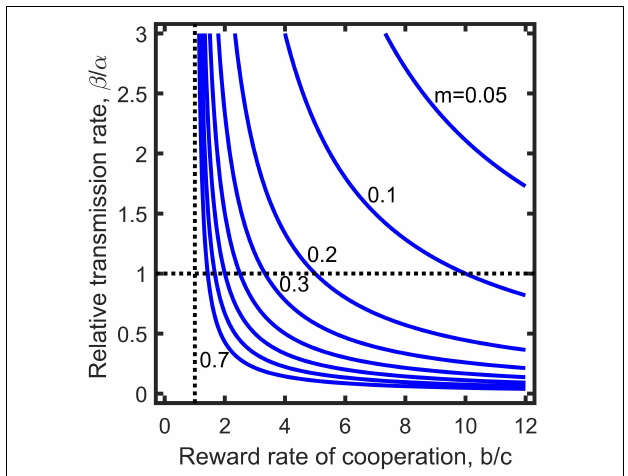
FIGURE 2 | Invasion threshold of pathogenic diseases to the population of cooperation evolution when transmission by interaction is absent (Equation 9). The parameter values taken above the curves assures invasion successful, otherwise, below which invasion fails. Vertical dashed line indicates cooperation benefit is equal to cost (i.e., b c = 1), and horizontal dashed line separates weak assortment (above the line, 0 < m < c b ) from strong assortment (below the line, m > c b